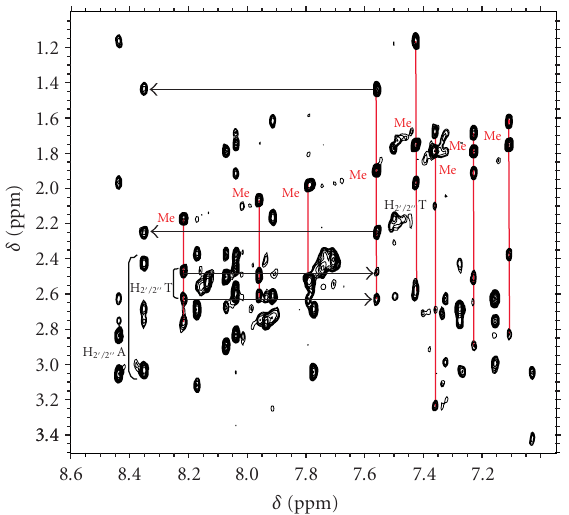
Figure 1: One-dimensional NMR spectra of d < pGGGTTA- GGGTTA > in H 2 O at 60 μ M (bottom) and 600 μ M (top) oligonu- cleotide concentrations (bu ff er conditions: 100mM NaCl, 25 mM sodium phosphate pH 7, T = 5 ◦ C).